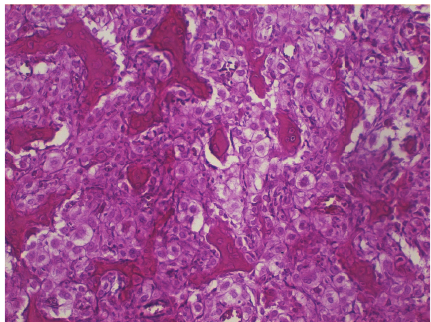
Figure 2: Typical area of clear cell chondrosarcoma diagnosed later from the original tumour